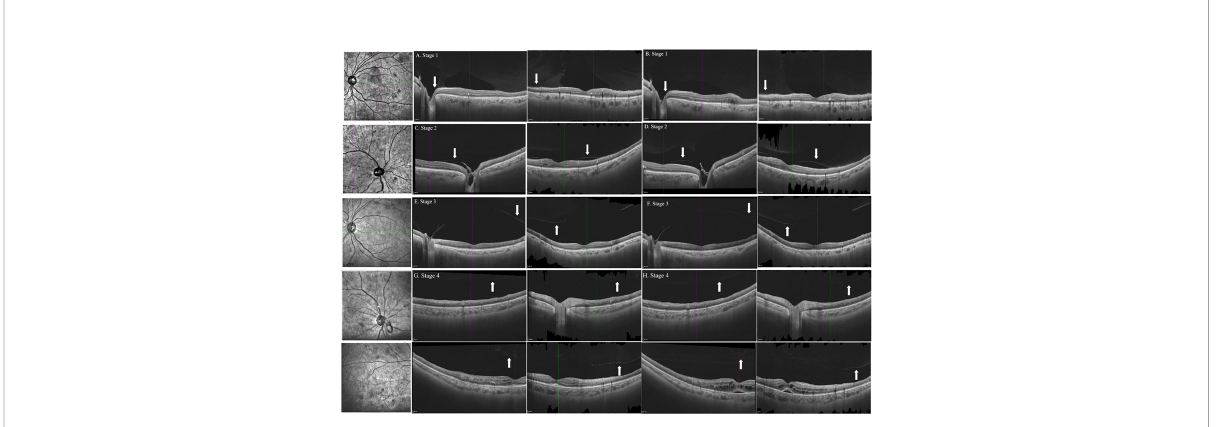
FIGURE 1 B-scan images of horizontal and vertical cross-sections of representative eyes with the stages 1, 2, 3, and 4 PVD in patients with DR at baseline (A, C, E, G) and follow-up (B, D, F, H) . Arrows indicated the posterior vitreous. PVD, posterior vitreous detachment; DR, diabetic retinopathy.